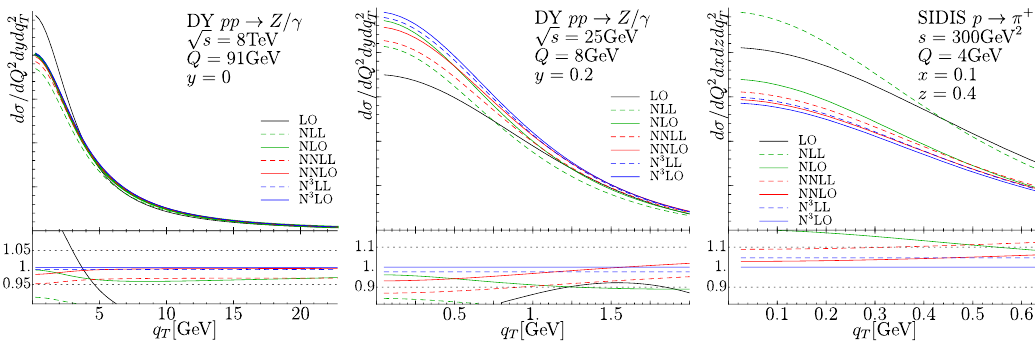
Figure 3 . The cross-section at di(cid:11)erent orders of TMD factorization and for di(cid:11)erent boson energies. The legend of the perturbative orders means that N k LO (N k LL) incorporates a k ( a k (cid:0) 1 -order) of the coe(cid:14)cient function, a k s